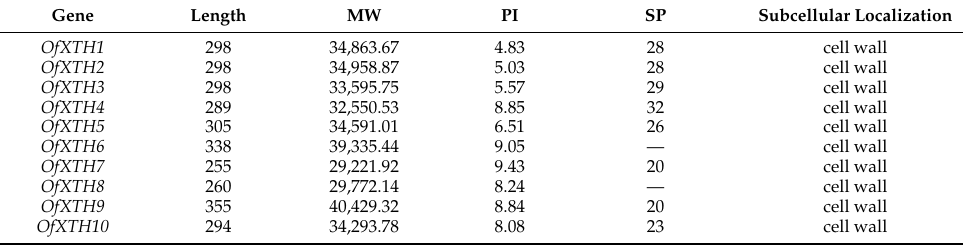
Table 1. The characteristic of OfXTH genes in O. fragrans